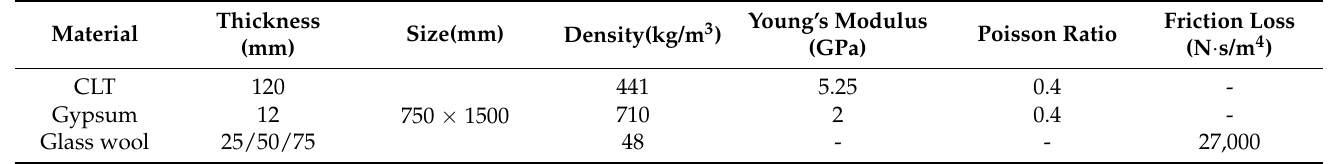
Table 1. Boundary conditions of wall